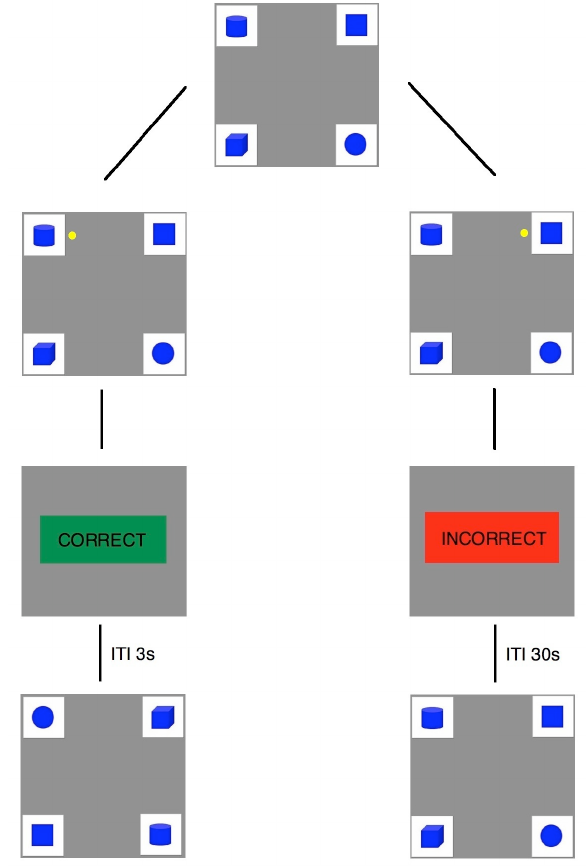
Figure 1. Series of frames displayed for participants during a trial. The left branch is an example of a correct choice; the right branch is an example of an incorrect